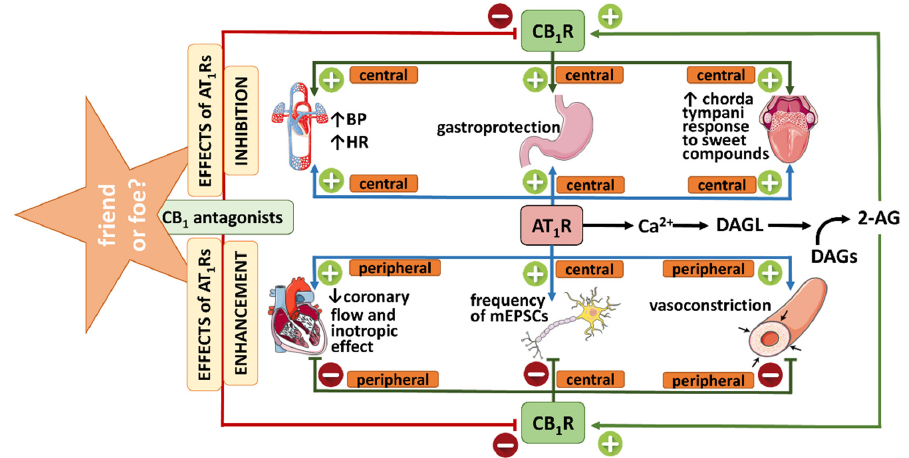
Figure 4. Influence of CB 1 receptor (CB 1 R) antagonists on the effects elicited by activation of AT 1 receptors (AT 1 R). Stimulation of AT 1 Rs leads to Ca 2+ ‐ signal generation and rapid biosynthesis of 2 ‐ arachidonoylglycerol (2 ‐ AG) from diacylglycerols (DAGs) by diacylglycerol lipase (DAGL) activation. If CB 1 R and AT 1 R activation lead to the same effect, CB 1 R antagonism will inhibit the AT 1 R ‐ mediated effect, i.e., will decrease blood pressure (BP) and heart rate (HR), gastro ‐ protection, or the chorda tympani response to sweet compounds (upper part of the figure). In the case of opposite effects of CB 1 R and AT 1 R activation, CB 1 R blockade will enhance the AT 1 R ‐ mediated effects, i.e., its positive inotropic action, its facilitatory effect on miniature excitatory postsynaptic currents (mEPSCs) or its vasoconstrictor effect (lower part of the figure). For the respective literature, see Table 2 and Section 3.2.1.